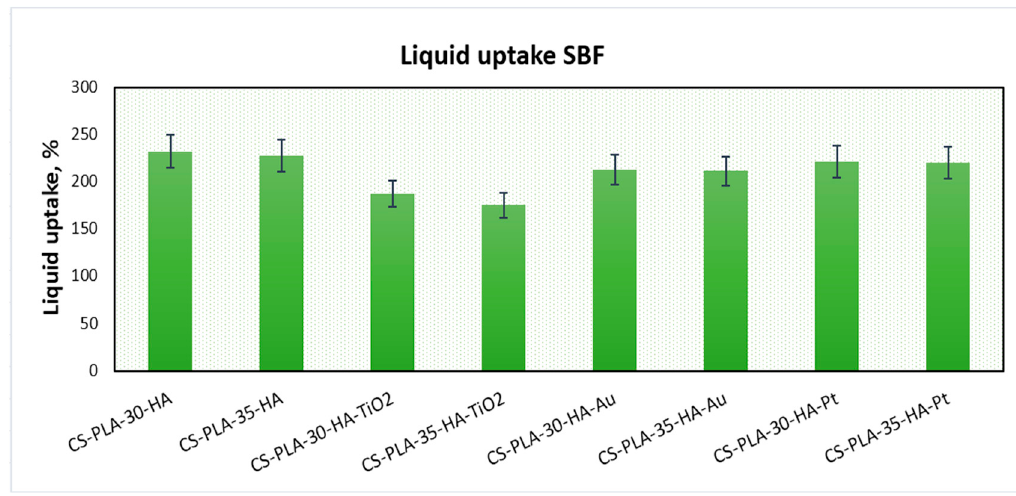
Figure 4. Swelling capacity of the prepared samples.